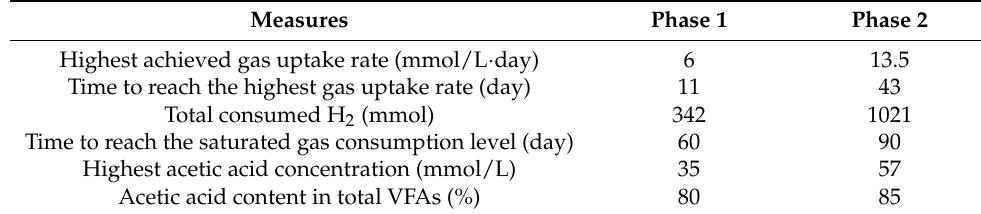
Table 1. The comparison of essential results for Phases 1 and 2.